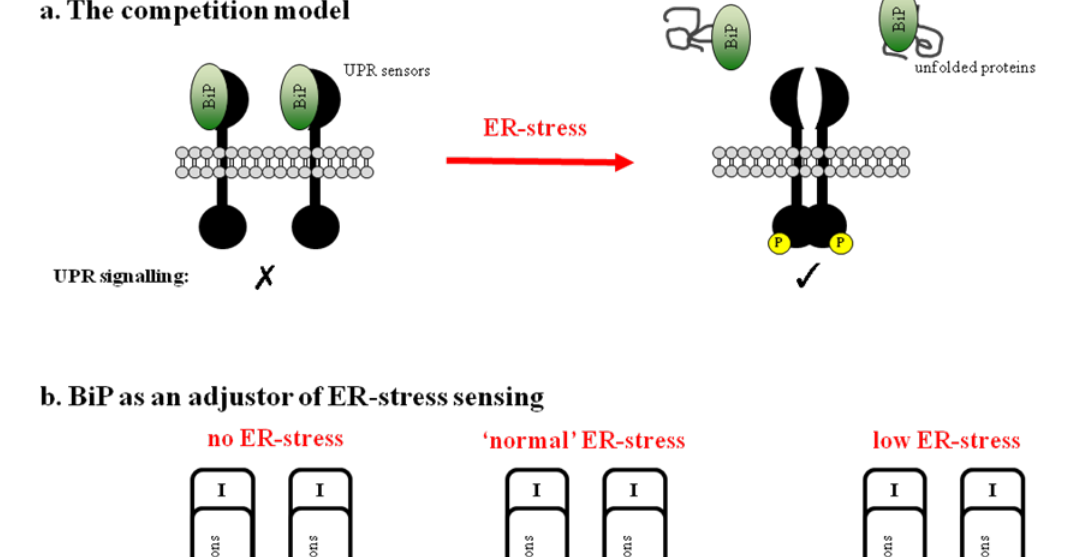
Figure 2. BiP-dependent UPR signaling activation ( a ) The competition model: BiP is normally bound to the ER sensor domains of IRE1, PERK and ATF6 and maintains them in an inactive state. Upon ER-stress, BiP dissociates to bind the unfolded protein substrates and alleviates repression of the UPR sensors allowing for their activation; ( b ) BiP as an adjustor of ER-stress sensing: BiP binds to region V of the ER sensor domains. Loss of BiP binding is not sufficient for activation of UPR signaling in the absence of ER-stress. Rather, “normal” ER-stress sensing requires core regions II and IV, and BiP serves as a fine tuner for instance to deactivate UPR signaling at low levels of ER-stress; ( c ) The BiP-release model: in the absence of ER-stress, ATP-bound BiP binds the luminal sensor domains via its nucleotide-exchange domain (NED). During ER-stress, BiP-binding to the unfolded protein substrates via its substrate-binding domain (SBD) activates hydrolysis of the bound nucleotide. The resulting conformational changes in BiP cause its dissociation from the sensor domains, which are then free to activate UPR